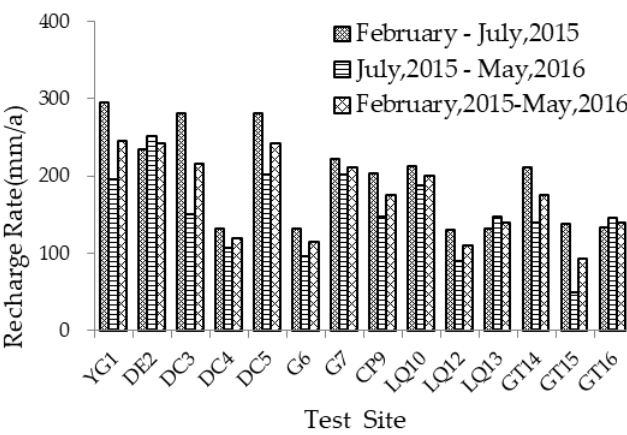
Figure 5. The recharge rate of groundwater in different periods.